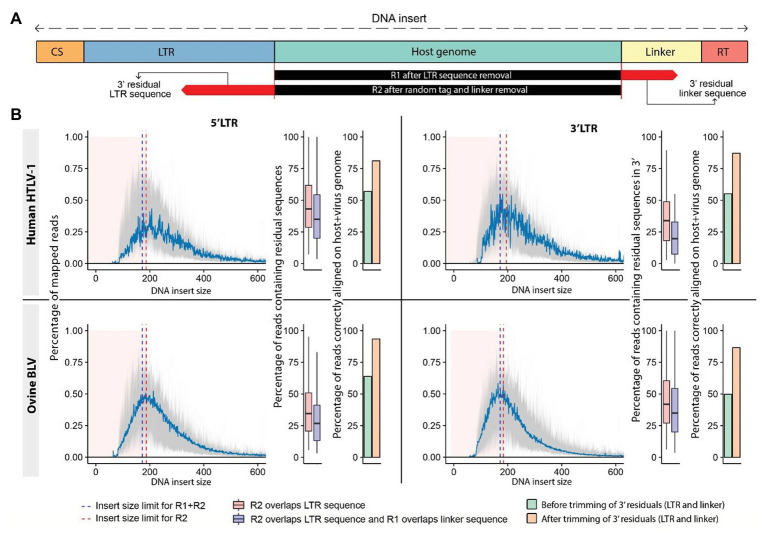
Trimming sequencing reads increases the number of reads supporting the proviral integration sites. (A) Schematic representation of sequenced DNA fragments. The DNA “insert size” is measured from the start to the end of the mapped portion of the DNA fragment, which corresponds to the host genomic sequence. R1 reads generated from small DNA inserts carry sequences corresponding to the linker of R2 at their extremity, while their R2 counterparts can contain a fraction of the LTR sequence found in R1 (residual sequences). (B) Distribution of insert sizes across mapped reads from HTLV-1 (human) and BLV (ovine) clonality libraries (mean represented in blue). Reads produced from short fragments affected by sequence overlap are shown by pink area. Overlap R2 (red dashed line), overlap both reads (blue dashed line). Boxplots: percentage of reads in each category. Barplots: percentage of reads mapping to the host genome prior to (green) and after (orange) trimming. 5' LTR data: left, 3' LTR data: right.